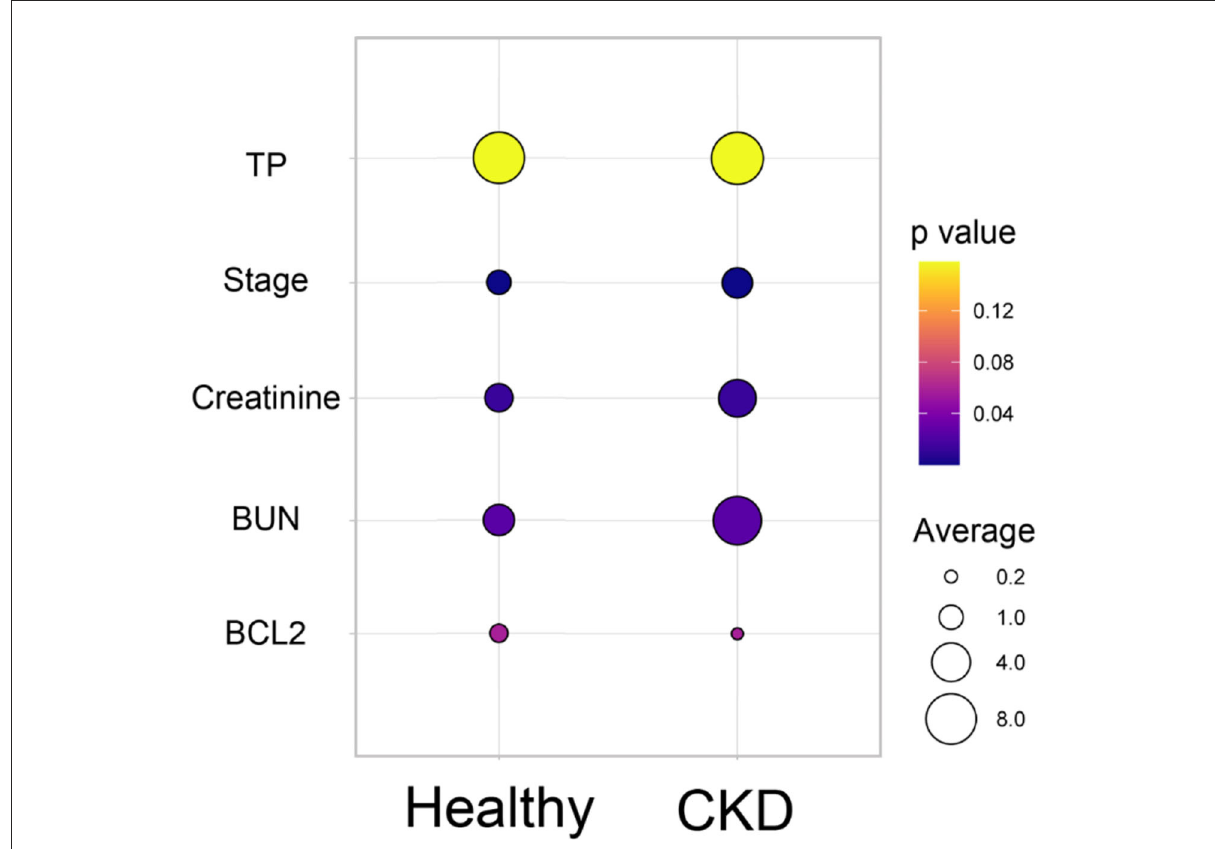
FIGURE3 Bubble plot of the comparison of the average blood parameters between the clinically healthy age-matched and CKD cats. The average of each blood parameter is shown in different circle sizes. The p -value of the different averages of each group is shown in the different colors.